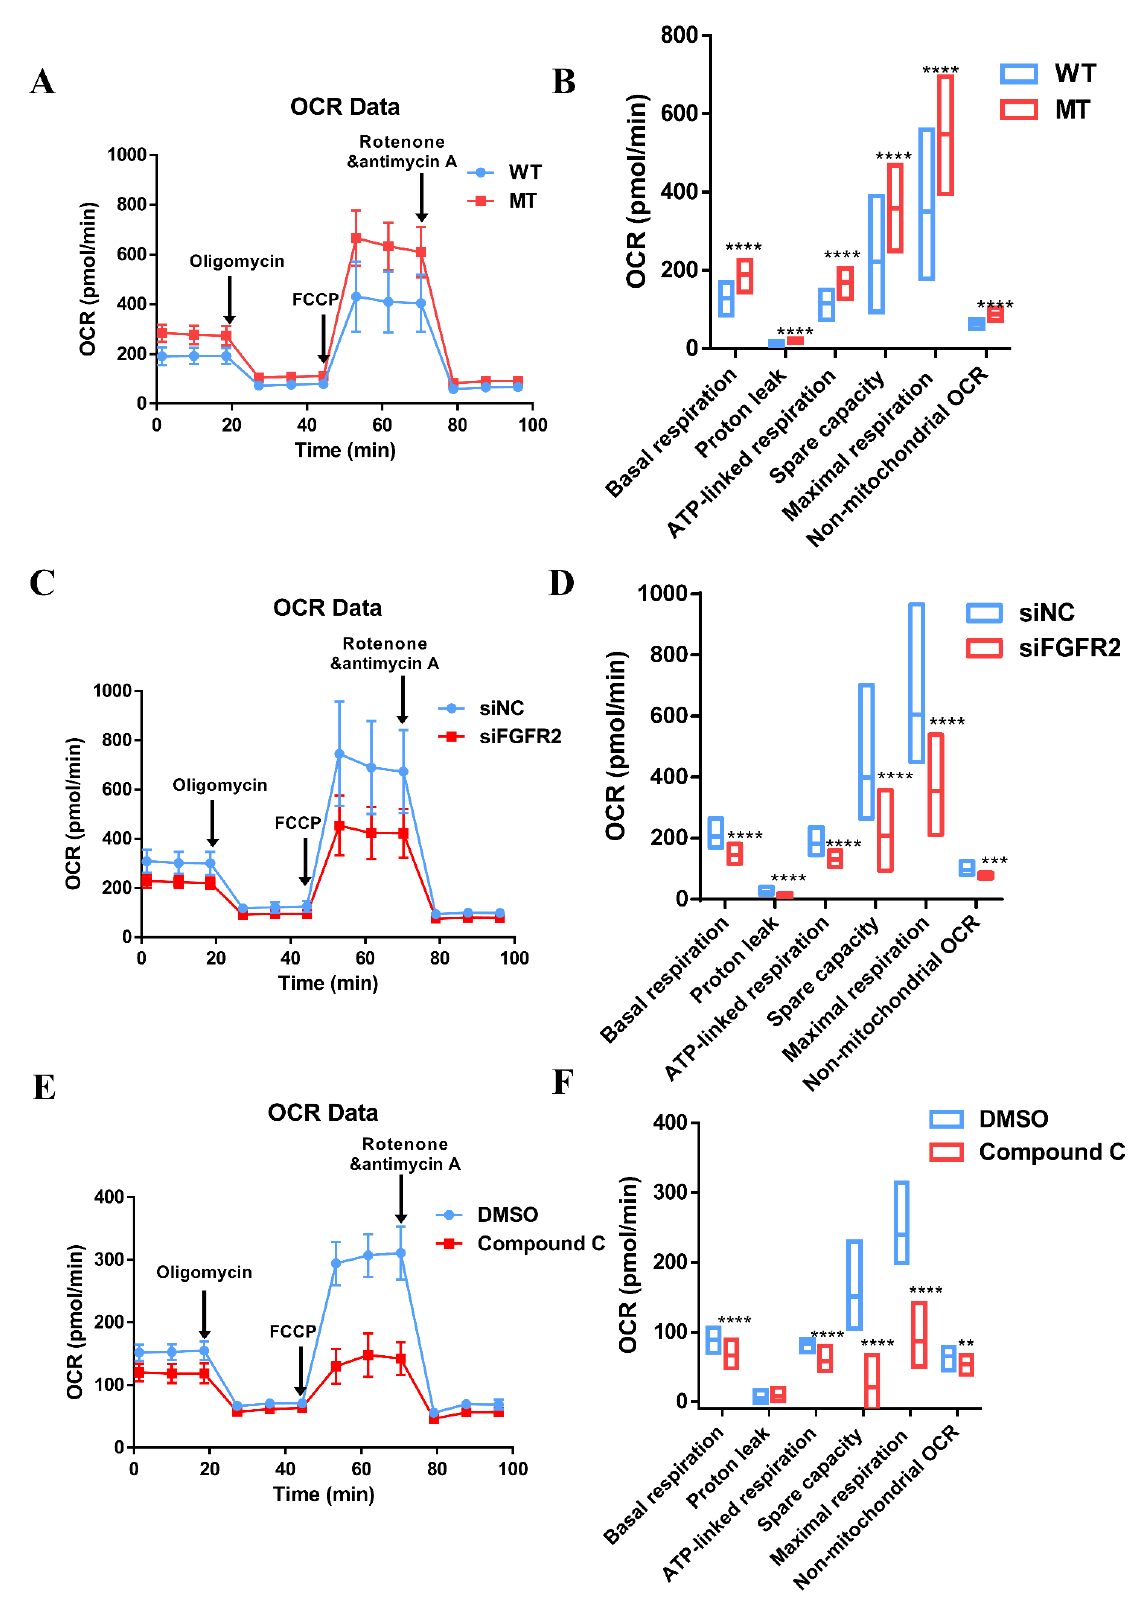
Figure 6. Mitochondria respiratory dysfunction influenced by the FGFR/FGFR2-AMPK pathway: ( A ) Traces of OCR in the WT group and MT group, respectively, in response to oligomycin,